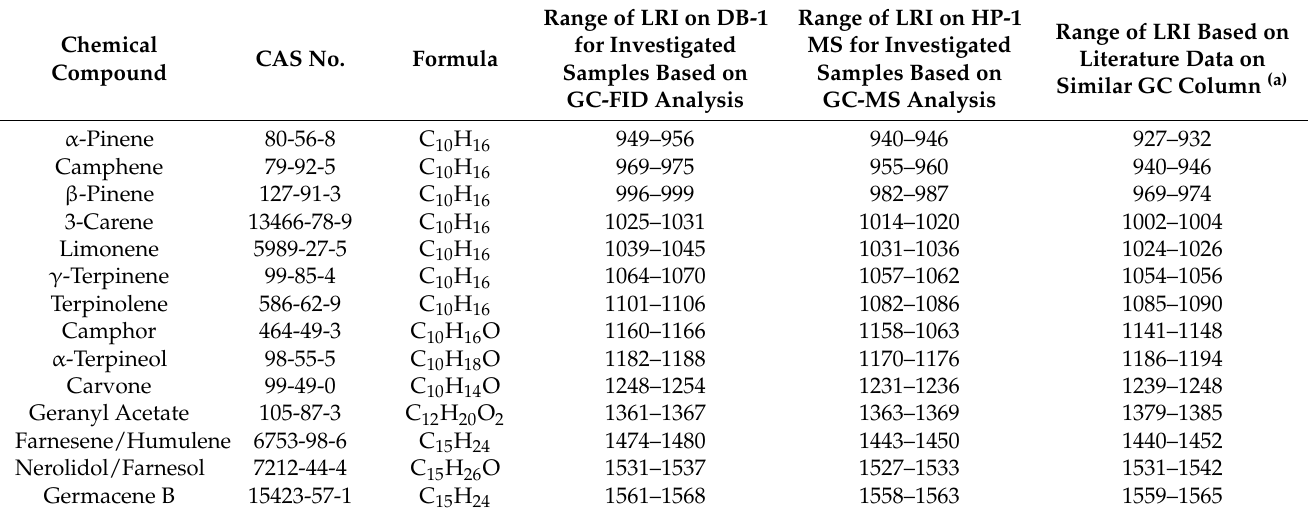
Table 3. Calculated retention indices of terpenes determined in atmospheric air on the investigated forest areas.